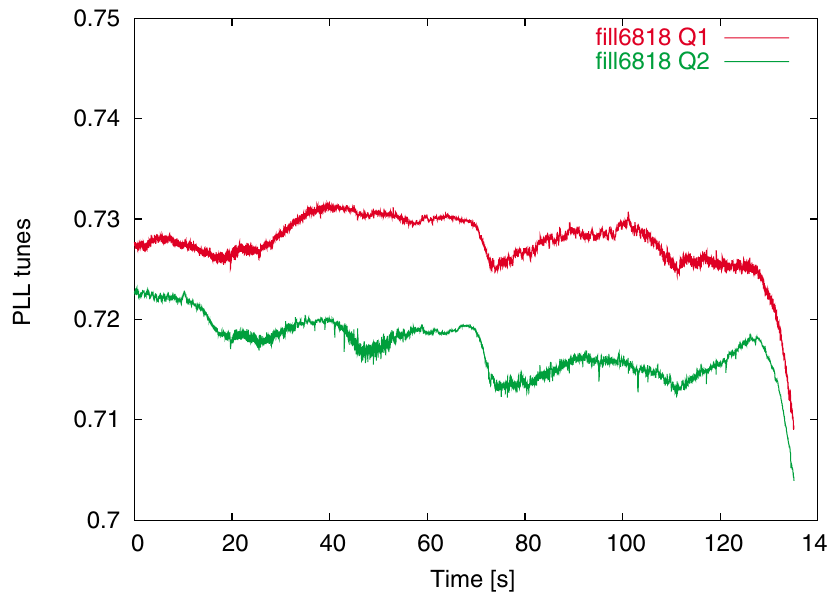
FIG. 5. (Color) The Yellow ring tunes in the second ramp with coupling